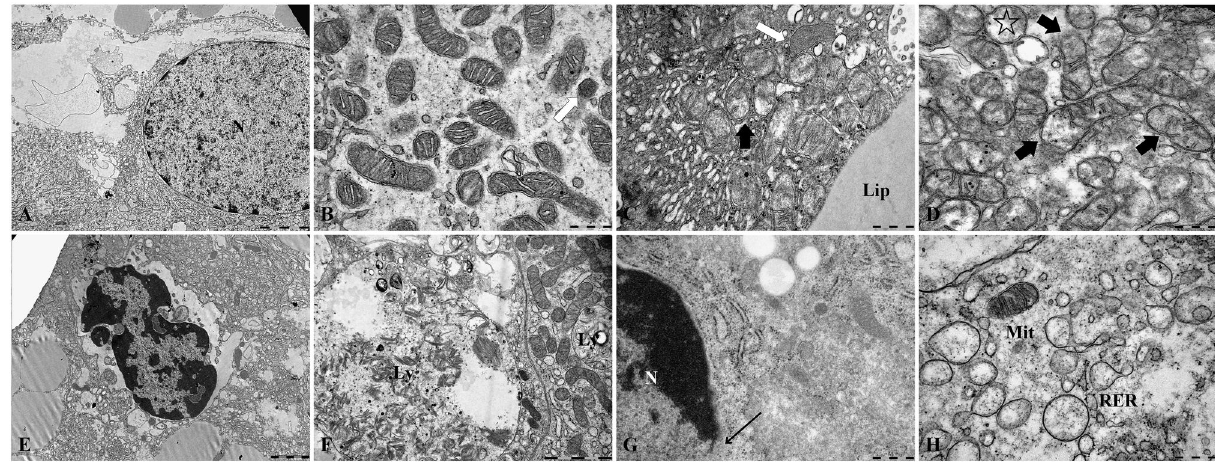
Figure 3. Pathological changes of the subcellular structure of the S. henanense hepatopancreas exposed to Cd. ( A ) Normal hepatopancreatic cell nucleus. Bar = 5 µm. ( B ) Normal mitochondria with a matrix of moderate electron density. Bar = 500 nm. ( C ) Mitochondria were damaged in the 7.12-mg/L Cd group. Mitochondria showed a matrix with low electron density and discontinuous membrane ( ➨ ). Primary lysosomes were seen ( ⇧ ). Bar = 500 nm. ( D ) Mitochondria were damaged in the 14.25-mg/L Cd group. The majority of mitochondria maintained their structure, but with a swollen matrix, reduction of the matrix density, shortening of the cristae, and rupture of a subset of the mitochondrial membrane ( ➨ ). Cristae disappeared and double-membrane vesicles were noted ( ✰ ) in severely damaged mitochondria. Bar = 500 nm. ( E ) Apoptotic cell in the 14.25-mg/L group. Chromatin was aggregated under the karyolemma and apoptotic bodies formed. Several morphologically normal mitochondria were seen. Almost all mitochondria turned into vesicles, and other organelles also disappeared. Bar = 2 µm. ( F ) Shows the autolysosomes and mitochondrion in two cells of the 14.25-mg/L Cd group. Bar = 2 µm. ( G ) Nucleus of a necrotic cell in the 28.49-mg/L group. The nuclear membrane was ruptured ( ← ) and most organelles were disappeared. Bar = 500 nm. ( H ) Damaged RER and Mit in the